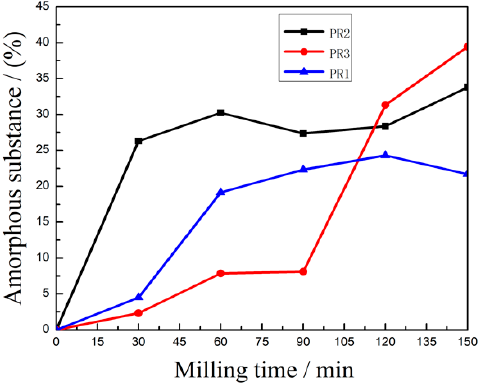
Figure 5. Amorphous substance of three PR powders at different milling times.